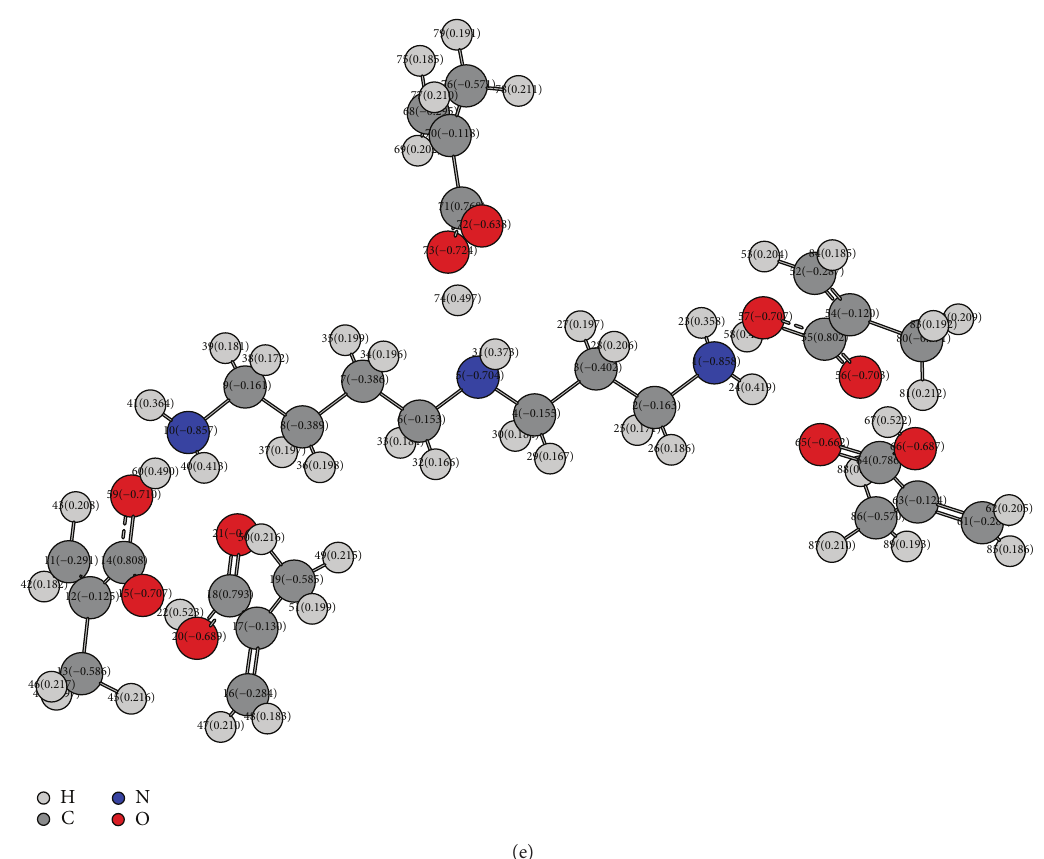
Figure 2: Conformations of the template molecule and the functional monomer at different imprint ratios. (a)–(e) are different geometric configurations at different imprinting proportions (1:1; 1: 2; 1: 3; 1:4; and 1: 5),